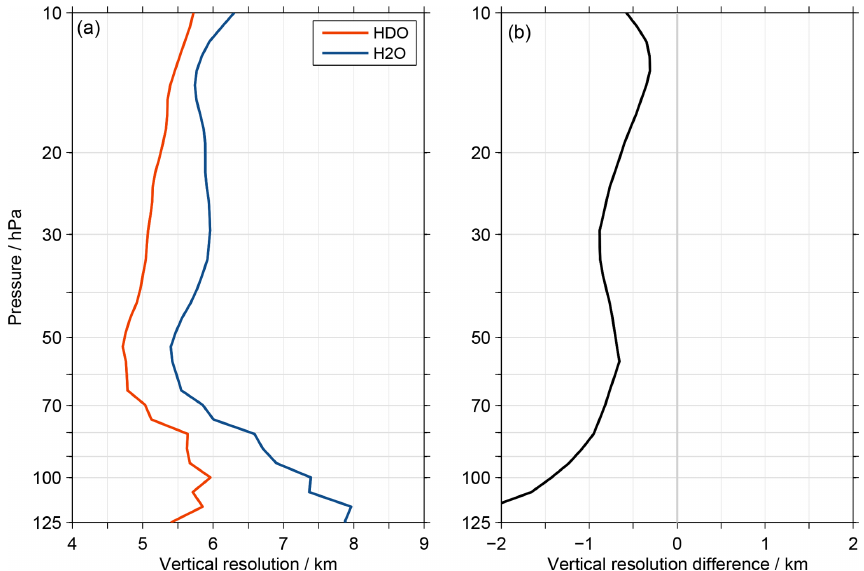
Figure 10. Panel (a) shows the average vertical resolution of HDO (red) and H 2 O (blue) for the MIPAS data set, considering all tropical observations. The resolution is derived from the averaging kernel rows using the full width at half maximum. The difference between the resolution of HDO and H 2 O is shown in panel (b)